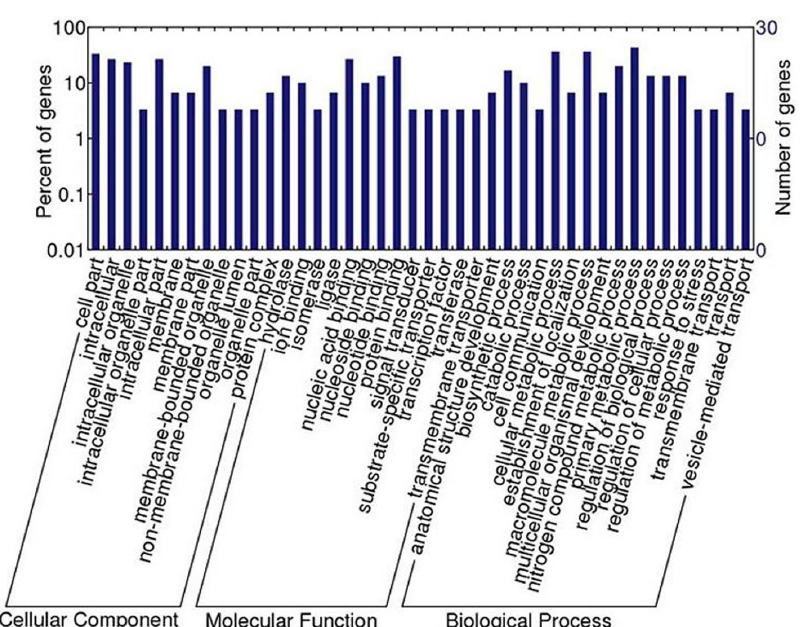
Figure 1. Gene ontology categories for the up-regulated proteins of T.spiralis larvae after their exposure to mouse intestine milieu. The identified proteins were classified into cellular component, molecular function, and biological process by WEGO according to their GO signatures. The number of genes denotes that of proteins with GO annotations.